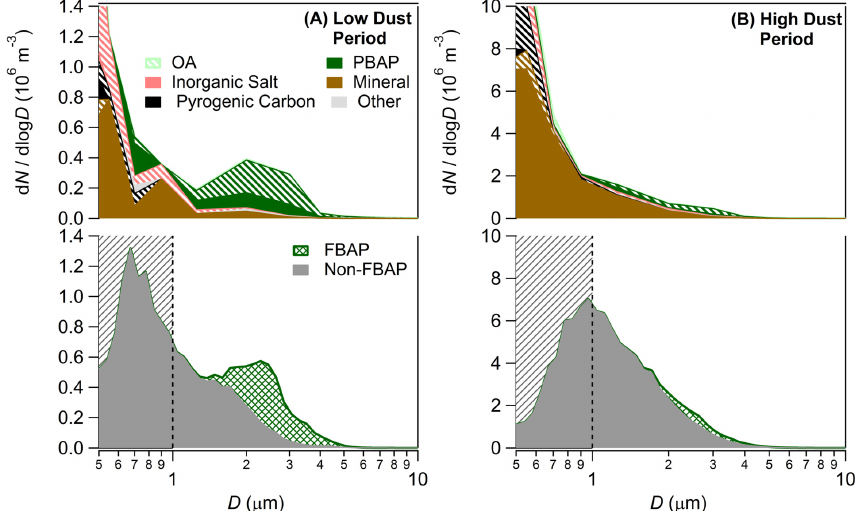
Fig. 5. Comparison of particle size distributions acquired from counting particles on filters using SEM (top panels) and in real-time from UV- APS (bottom panels). Colored areas are stacked in each case such that top line reflects the total concentration from each analysis technique. Upper panels: regions of solid color indicate uncoated particles, diagonal bars indicate particles coated with organic material. (A) Low Dust period (Average of sample numbers M04, M08, M12; 5608min total), (B) High Dust period (Average of sample numbers M07, M30; 3867min total). Size distribution from each analysis plotted with respect to its own method of particle size determination. Upper SEM panels shown versus physical diameter ( D p ) , as defined by visual determination through microscopy. Lower UV-APS panels shown versus aerodynamic diameter ( D a ) , operationally defined as the size a particle acts in a flowing stream of air as if it were condensed into a sphere of unit density (DeCarlo et al.,